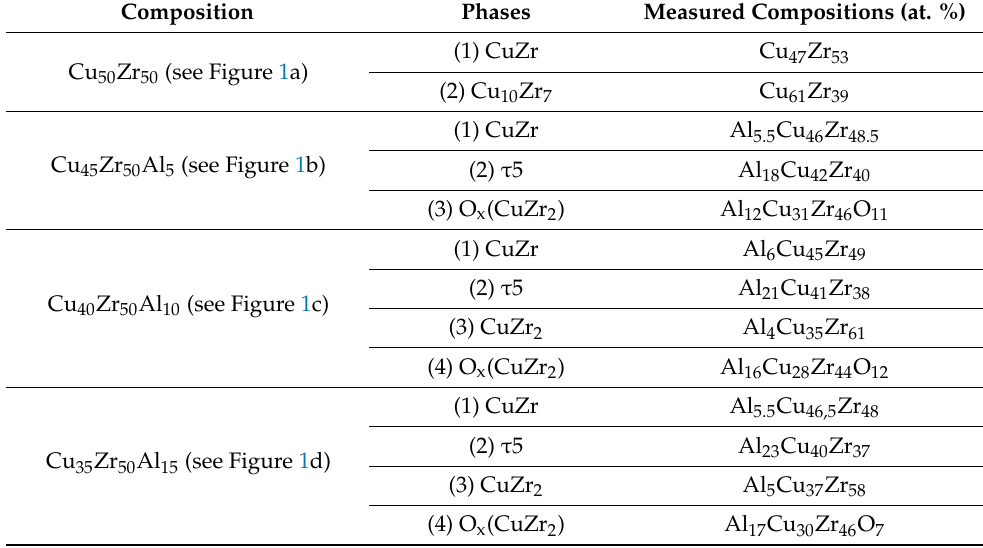
Table 1. EDS measurements of the CuZr based sample, performed on the sites depicted in Figure 5. Composition Phases Measured Compositions (at.